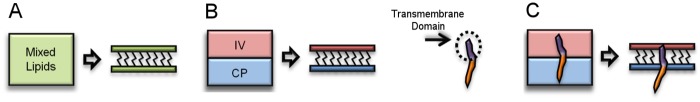
Methodology of membrane self-assembly.(A) The self-assembly of evenly mixed lipids result in a membrane with symmetric leaflet. (B) two stacked boxes filled with different lipids for each intravesicular (IV) and cytoplasmic (CP) leaflet self-assembles in an asymmetric membrane. (C) The same method can be used in simulations of membrane-protein insertion by including the membrane protein in the initial set-up the self-assembly. The transmembrane domain (in purple) of the protein aligns itself with the hydrophobic core of the membrane.